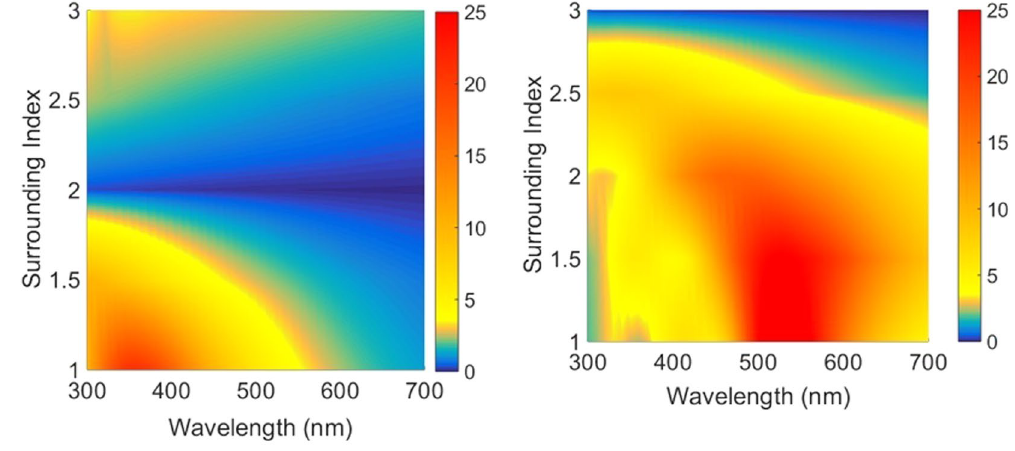
Figure 6. ( a ) Scattering cross section of rod with index ( a ) 2 + 0.1i and ( b ) 3 + 0.1i plotted as a function of varying surrounding medium index and